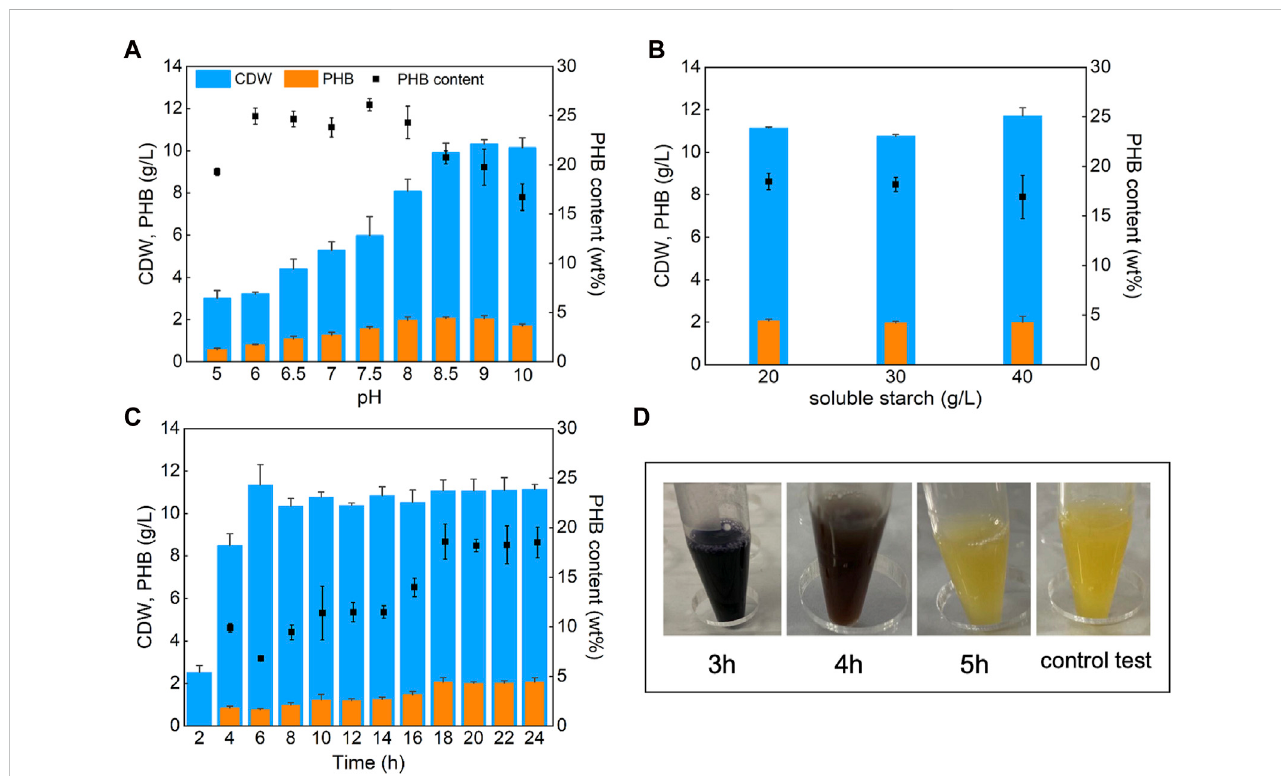
FIGURE 1 Effects of pH, substrate concentration, and culture time on PHB production. V. alginolyticus LHF01 was cultivated in TYS50 medium in shake fl asks at 37 ° C,200 rpm. Dataareexpressedasaveragesandstandarddeviationsofthreeparallelexperiments. (A) ,thepHwassetat5,6,6.5,7,7.5,8,8.5,9,and10. (B) , the starch concentration gradient was 20, 30, and 40 g/L. (C) , the samples were taken every 2 hours to determine CDW and PHB accumulation. (D) , starch consumption was indicated by adding iodine solution to the cultures.